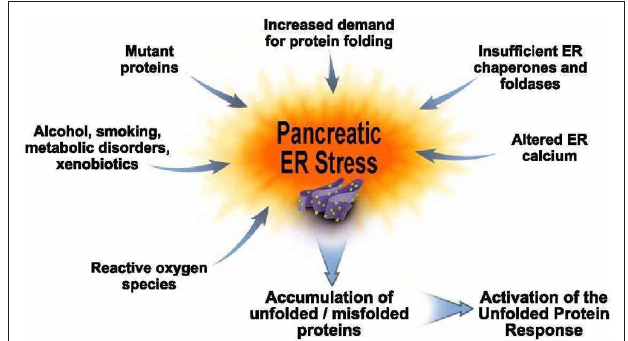
FigURe 1 | Pancreatic eR stress. This figure depicts factors we hypothesize cause pancreatic exocrine cell ER stress. For example, an increased folding demand will result when there is a need for increased digestive enzyme synthesis. Increased expression of chaperones and foldases are needed for processing these proteins. Altered ER calcium levels as occurs during forms of pancreatitis can also cause ER stress. On the left hand side of the figure are situations in which pancreatic ER stress is further amplified. These include genetic mutations in digestive enzymes; alcohol abuse; smoking; metabolic disorders such as diabetes and hyperlipidemia; xenobiotics such as drugs and intestinal bacterial metabolites; and reactive oxygen species that are generated in many of these situations as well as during acute and chronic pancreatitis. These pancreatic ER stressors lead to further accumulation of unfolded and misfolded proteins which, in turn, lead to further activation of the Unfolded Proteins Response in an attempt to adapt the pancreas to function in the face of the ER